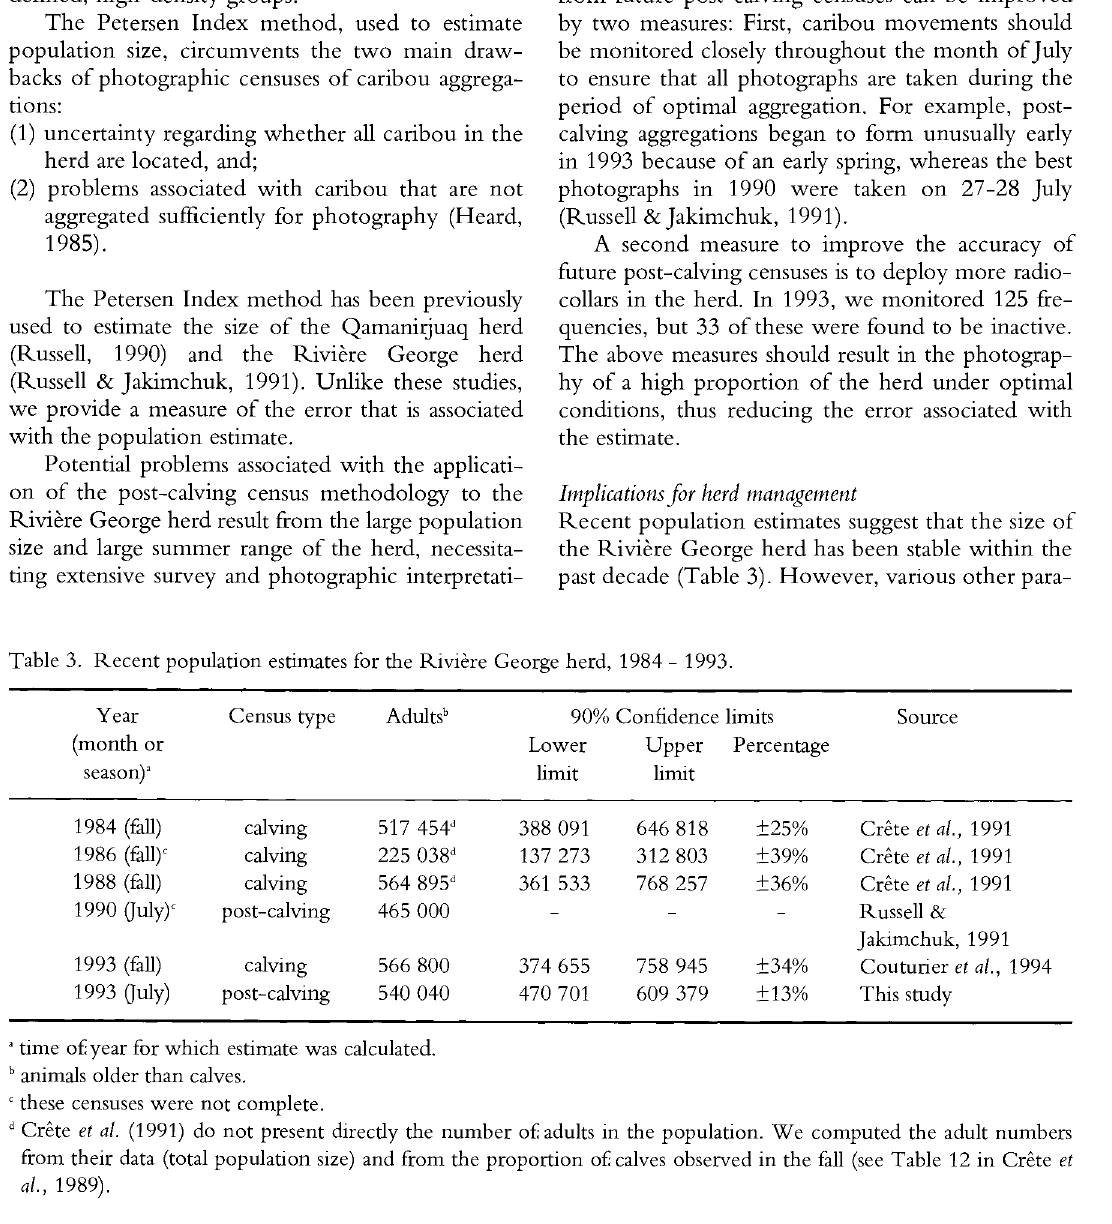
Table 3. Recent population estimates for the Rivière George herd, 1984 -